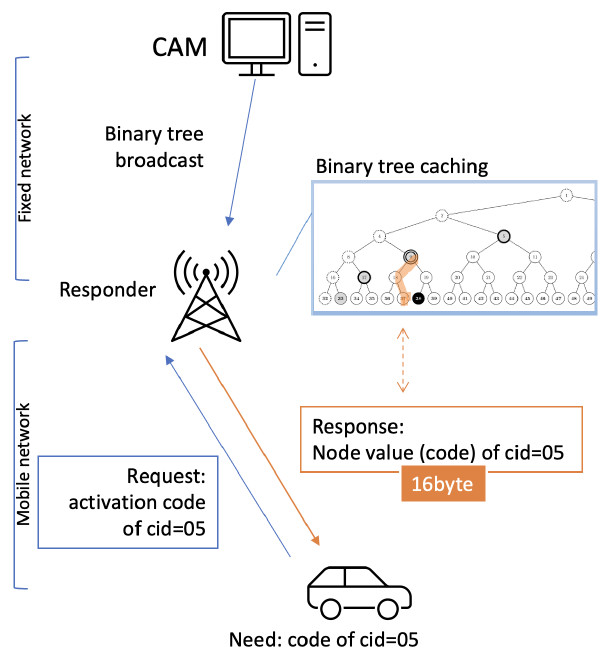
Figure 7. Unicast